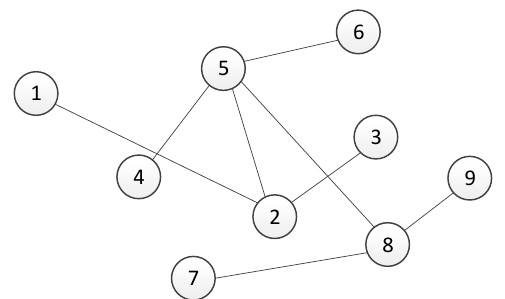
Figure 2. Graph topology of channel B of the system with 9